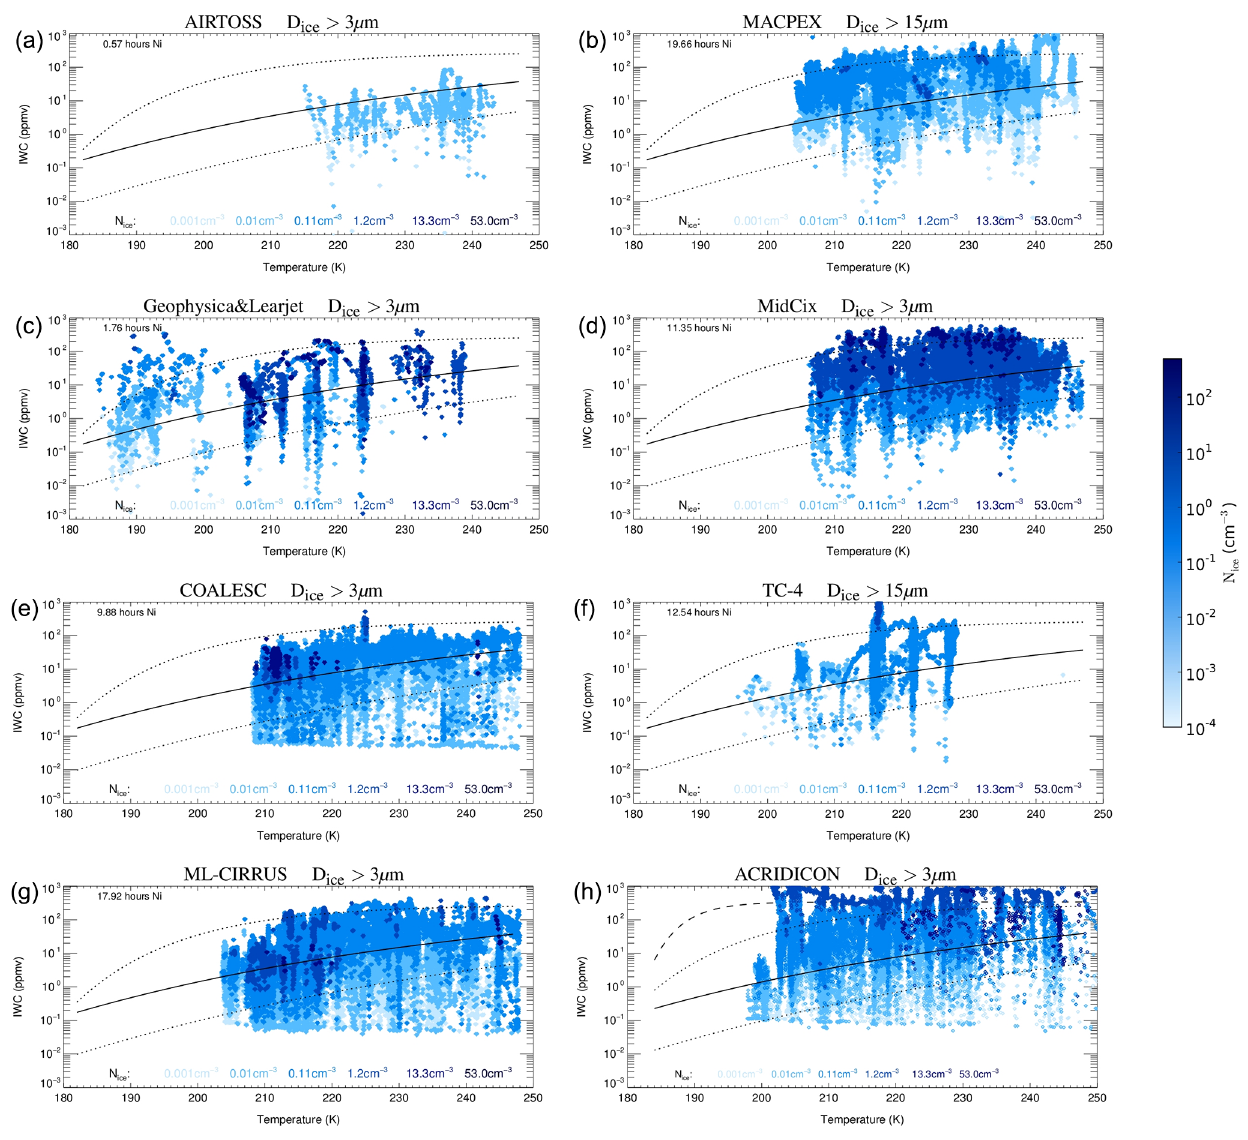
Figure 3. Observations of IWC vs. temperature, color coded by N ice ( = total number of ice crystals > D ice ). Left column: European field campaigns, right column: US/Brazil field campaigns. Total simultaneous IWC- N ice measurements 85.7h. Solid line: median IWC, dotted lines: upper and lower bound of the core IWC band (from observations of Schiller et al., 2008 and Luebke et al., 2013. For instrumentation and campaigns see Table 1 and Fig.